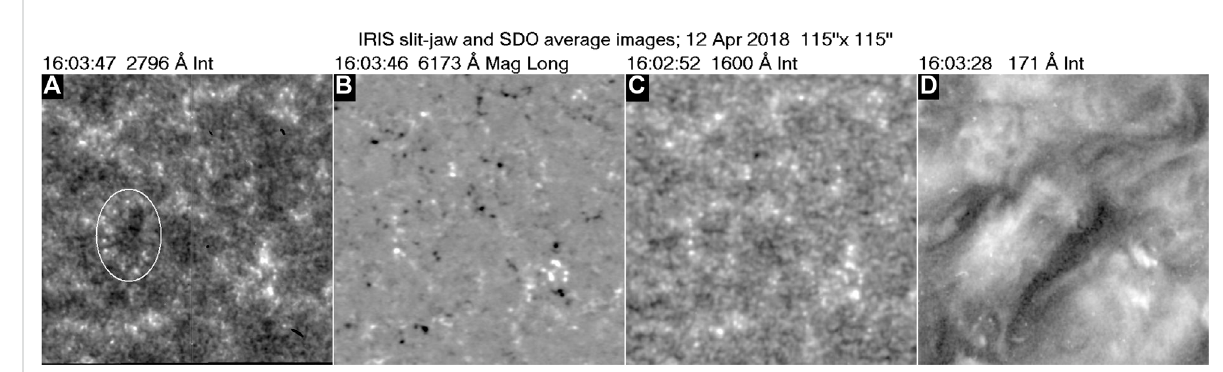
FIGURE 3 Images of a quiet Sun region: (A) in the Mg II k line; (B) an HMI magnetogram, saturated at ± 50 G; (C) in the AIA 1600 Å band and (D) in the AIA 171 Å band. Images have been averaged over 20min, to reduce the effect of 5-min oscillations which is very prominent at 2796 and 1600 Å. The white ellipse in panel a marks a prominent supergranulation sell. Figure made by the authors from IRIS, AIA and HMI